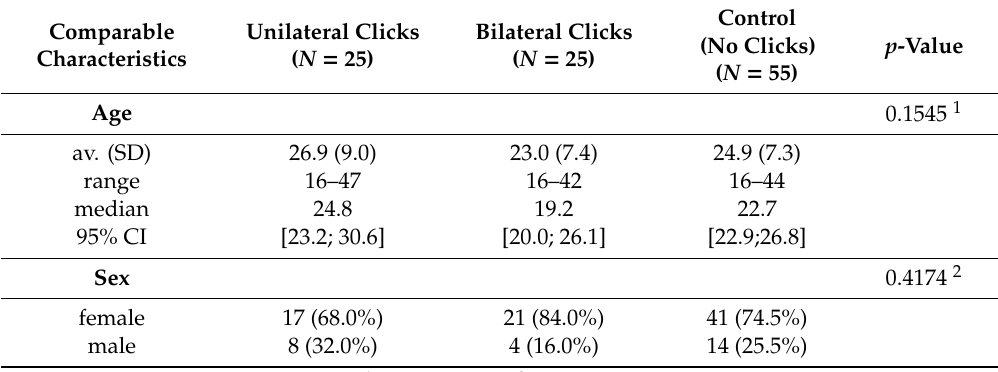
Table 1. General characteristics (including sex and age) of patients with unilateral, bilateral, and without any clicks in temporomandibular joints